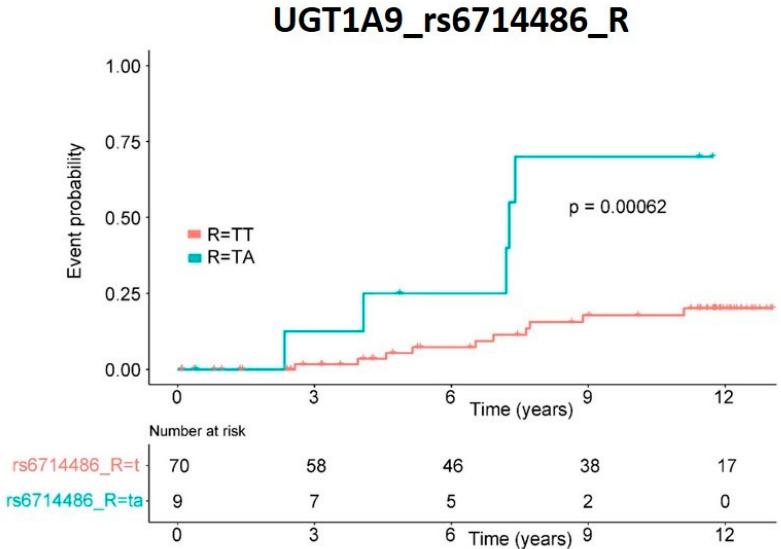
Figure 3. De novo cancer risk. Kaplan–Meier representation of patients’ risk of cancer de novo appearance depending on genetic variants in recipient UGT1A9 rs6714486 SNP. Significance was obtained by log-rank analysis.